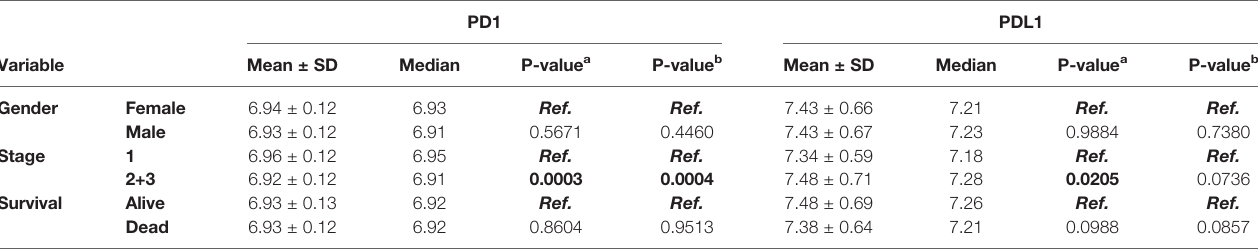
TABLE 4 | Correlation of PD1 and PDL1 gene expression with clinical parameters of squamous cell carcinoma lung cancer patients in the validation dataset.